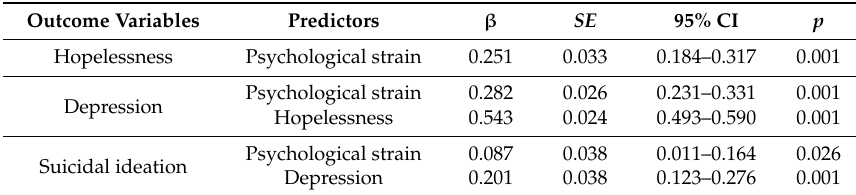
Table 4. Path analysis.